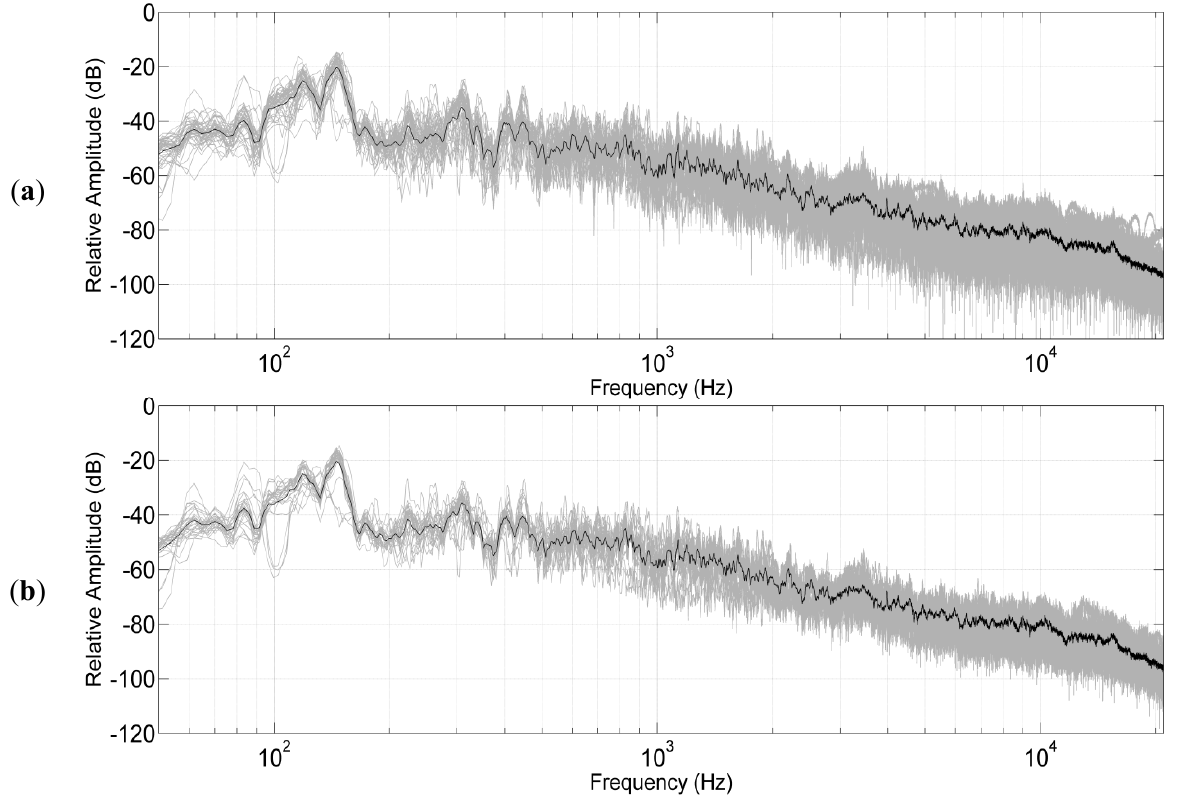
Figure 9. ( a ) Spectrums of single pulses in 0.5 m of SWH. Each green line represents one pulse ( N = 50), the red line represents the average of all green lines; ( b ) Spectrum of double pulses in 0.5 m of SWH. Each green line represents one pulse ( N = 50), the red line represents the average of these lines. Frequency on the x -axis and amplitude on the y